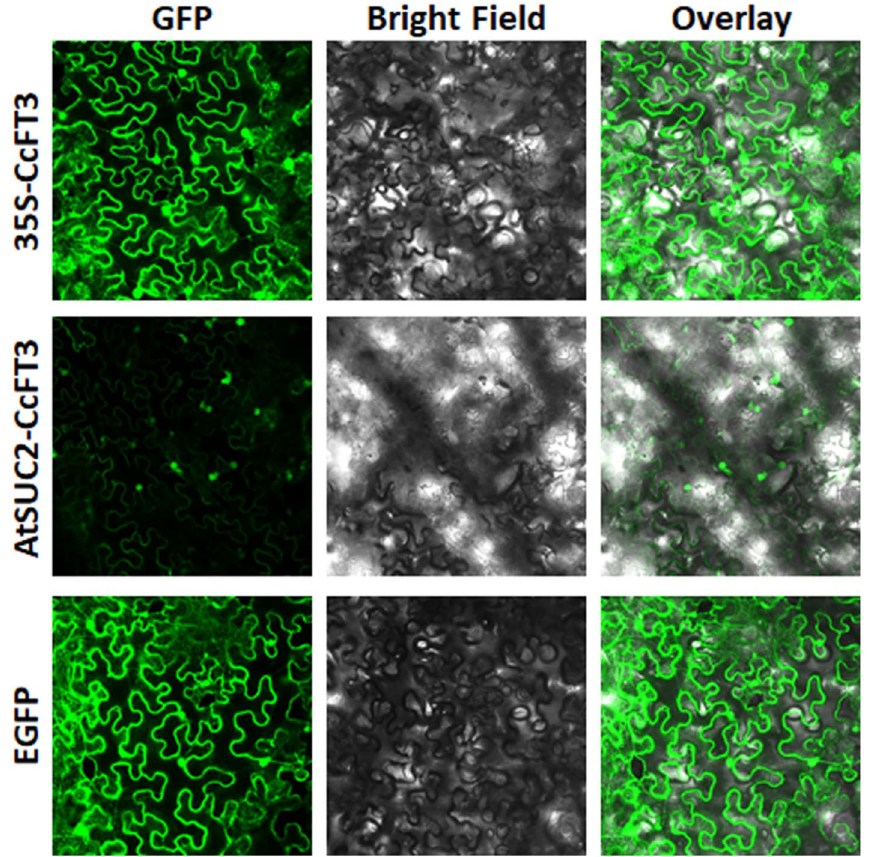
Figure 7. Confocal micrographs showing transient expression of the CcFT3-EGFP fusion protein. Confocal micrographs of GFP, transmission white light (Bright field) and an overlay. Cytoplasmic and nuclear